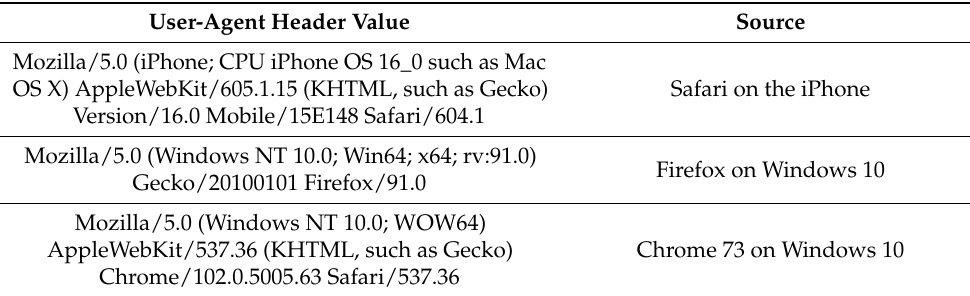
Table 3. Example of user-agent header value and their